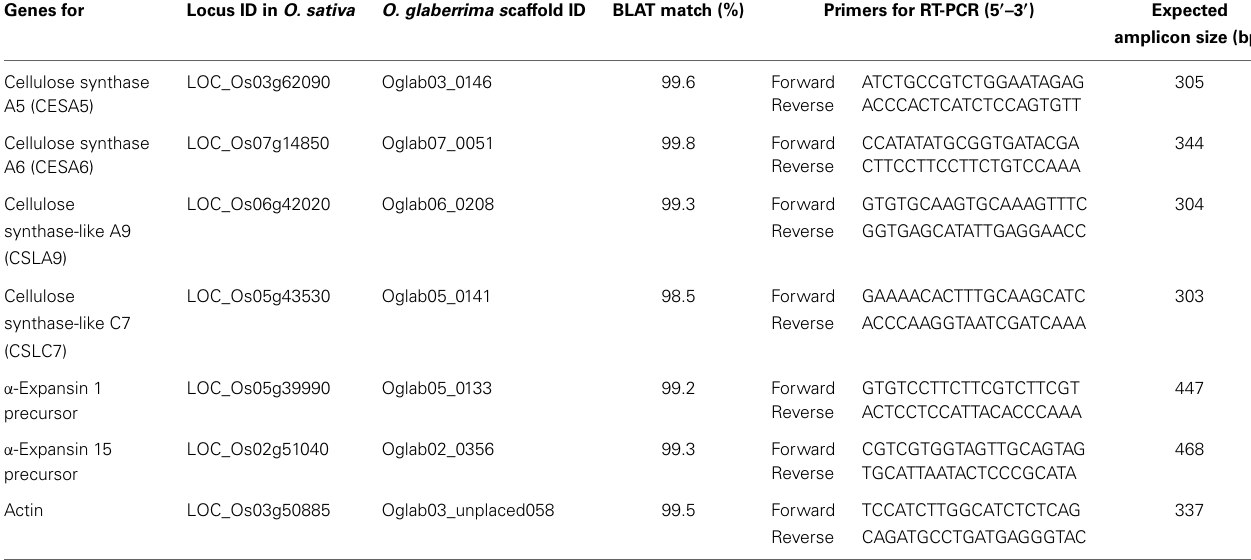
Table 1 | Cell wall-related genes examined for expression in Oryza glaberrima and O. sativa infected with Rice tungro spherical virus . Genes for Locus ID in O.